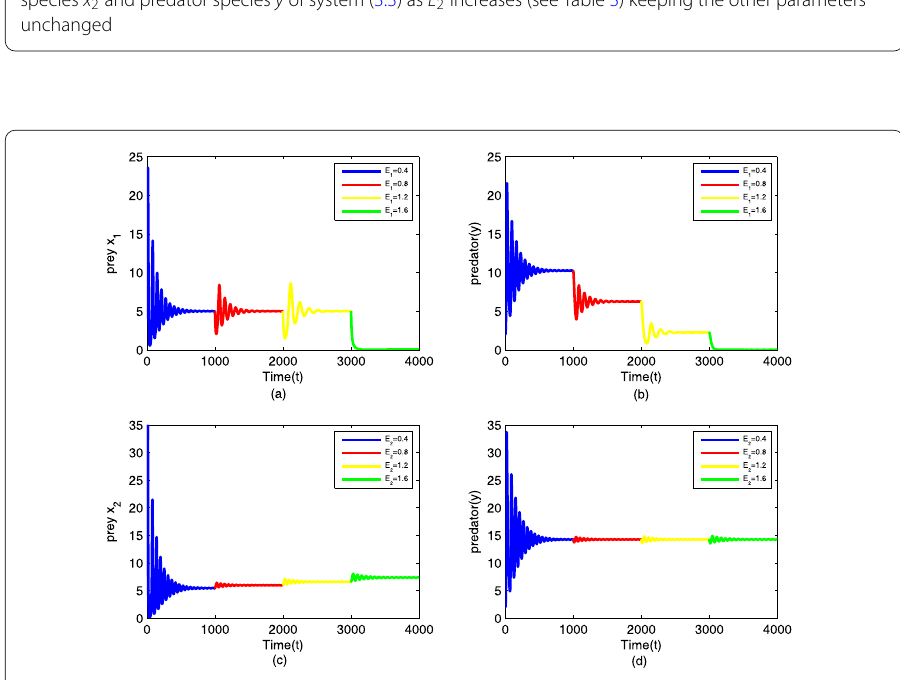
Figure 13 Path of the system species as E 1 ( E 2 ) increases periodically. ( a ), ( b ) Path of prey species x 1 and predator species y as E 1 increases periodically. The other parameter values are given in (7.5). ( c ), ( d ) Path of prey species x 2 and predator species y as E 2 increases periodically. The other parameter values are given in (7.5)